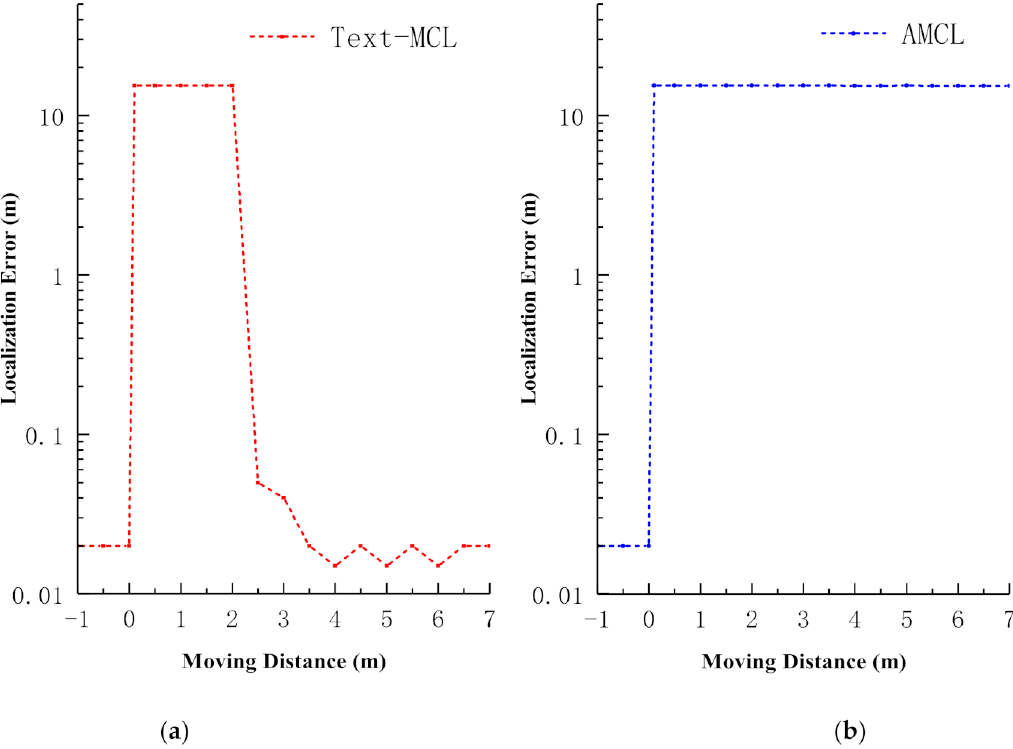
Figure 14. The result of the kidnapped robot problem. ( a ) the result of proposed method; ( b ) the result of the conventional